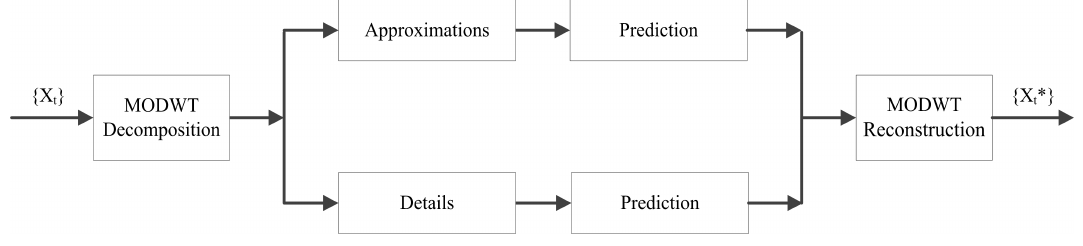
Figure 2. Process of MODWT